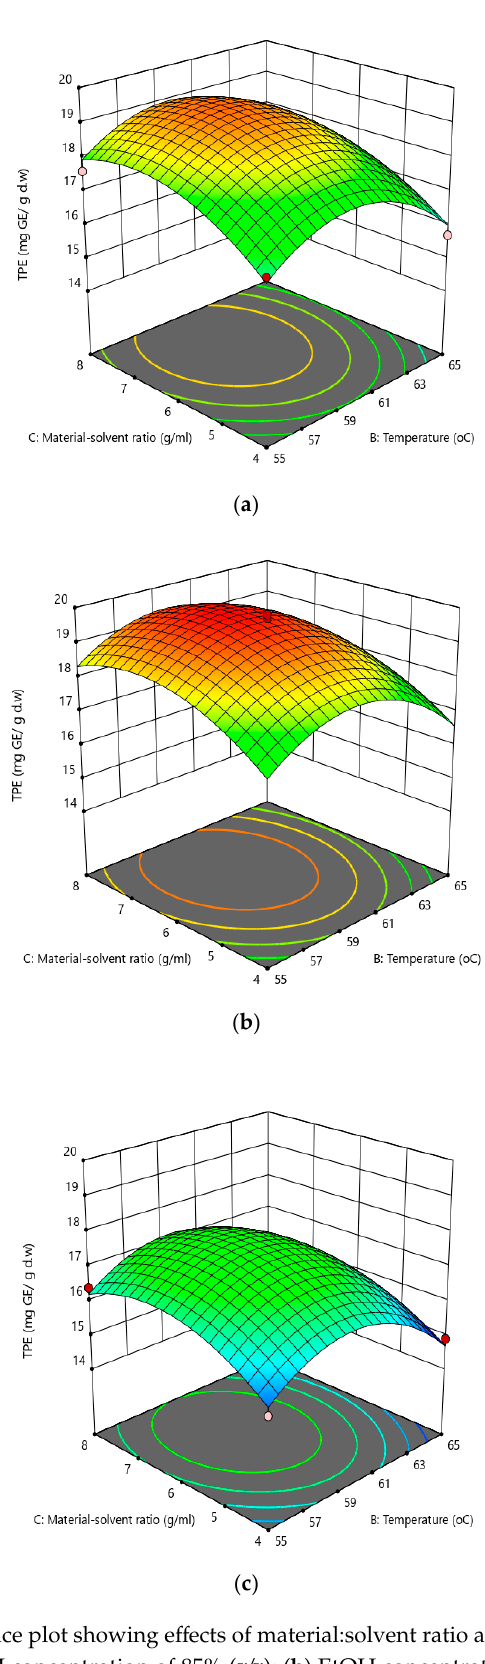
Figure 11. Response surface plot showing effects of material:solvent ratio and extraction temperature on yield of TPC. ( a ) EtOH concentration of 85% ( v/v ); ( b ) EtOH concentration of 90% ( v/v ); ( c ) EtOH concentration of 95% ( v/v ).